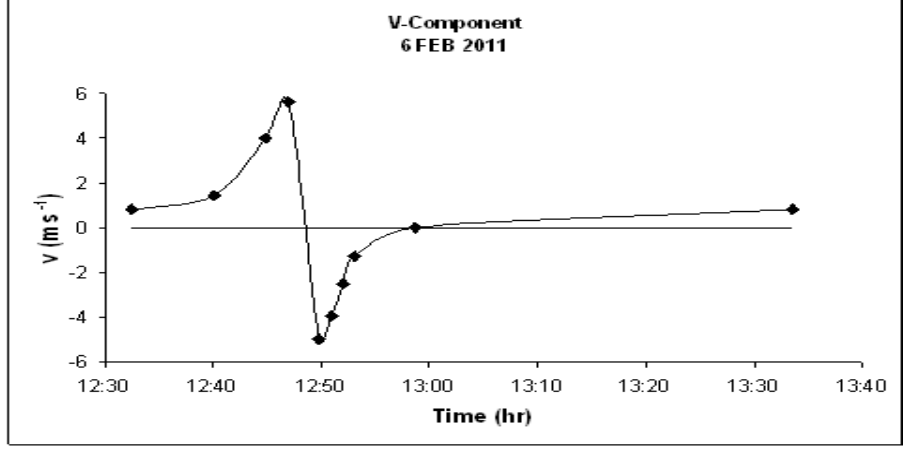
Figure 5. Time series of the north-south wind at the center point shown in Figure